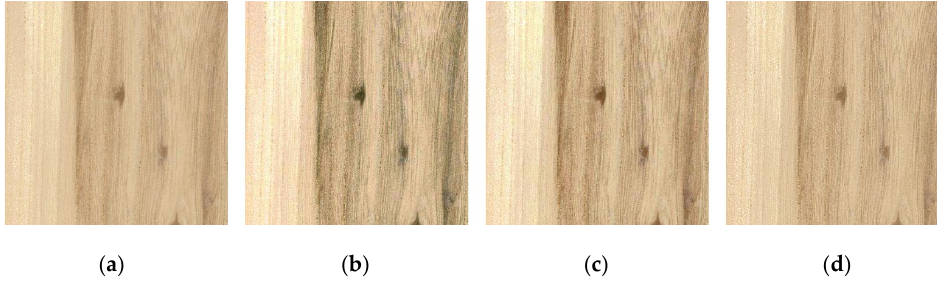
Figure 9. The No.10 images processed by ( a ) the Gaussian histogram specification; ( b ) the Gaussian method and the histogram extension method whose α c values were obtained by Equation (5); ( c ) the Gaussian method and the histogram extension method whose α c values were from a unified 1.5; ( d ) the USM at the 50 (%), 1.5 (pixels), and 0 (levels) setting.